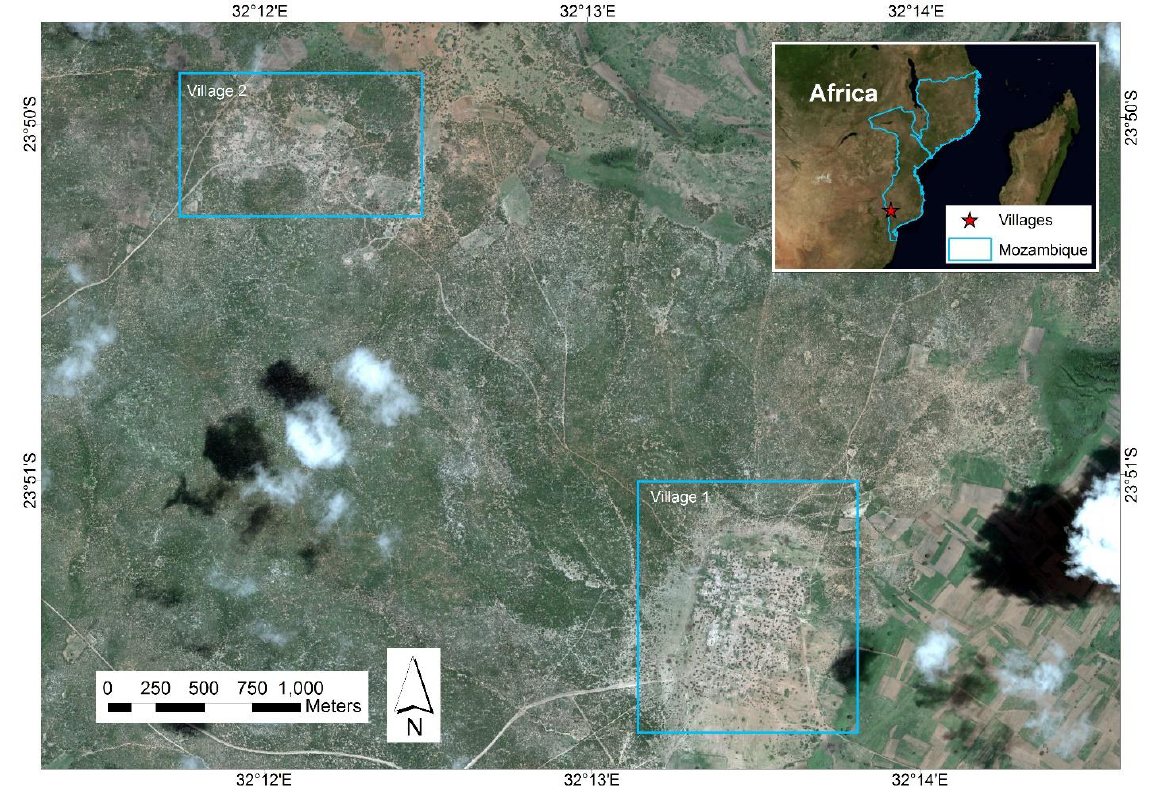
Figure 1. The study area, enclosed by two blue boxes, as shown in a QuickBird image captured on 22 February 2004.